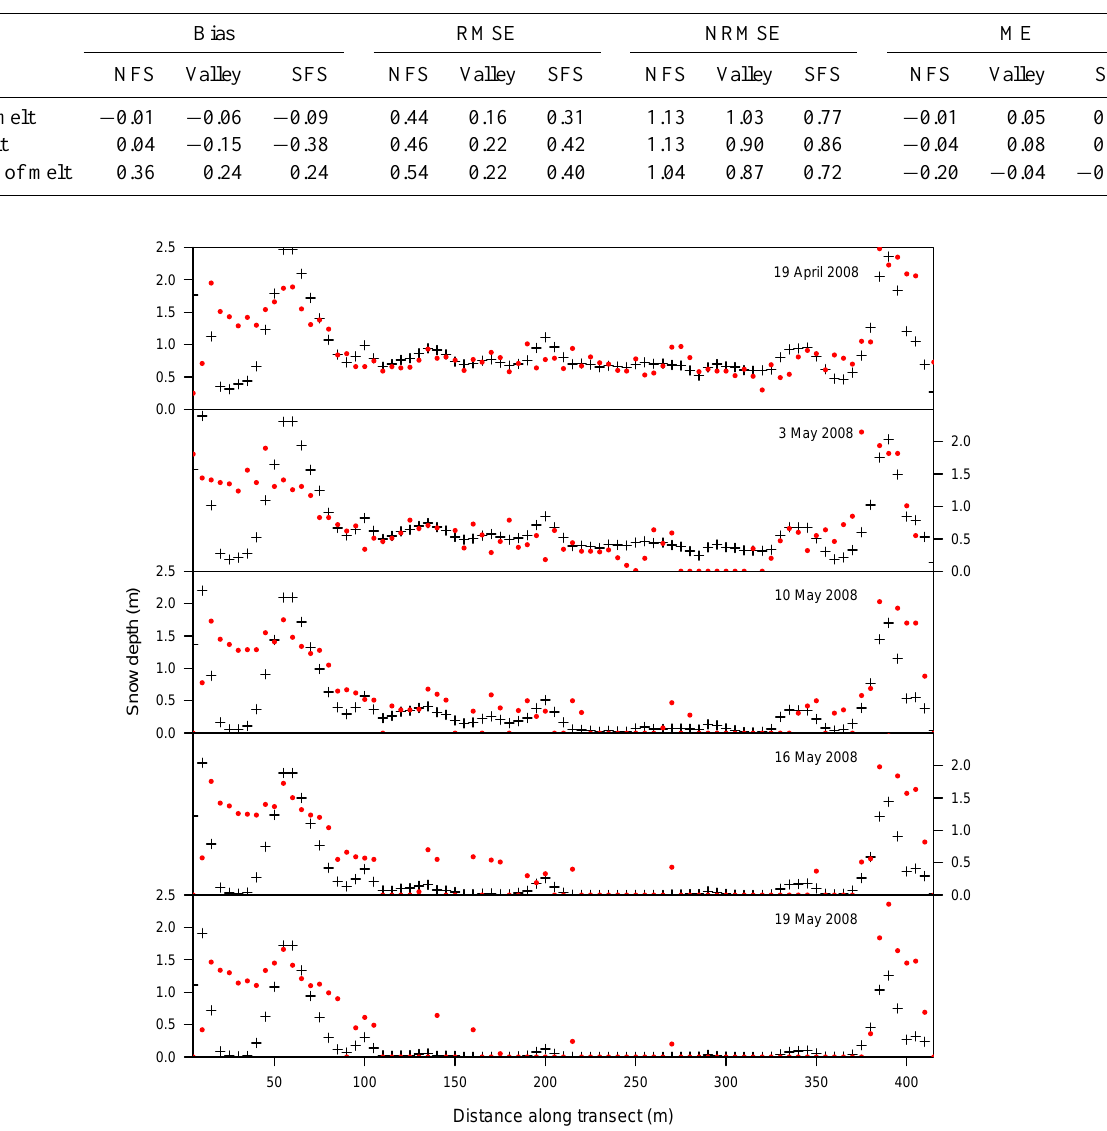
Figure 8. Modelled (black) vs. measured (red) snow depths along a transect in the GB valley. The transect goes through the northeast-facing slope (0–155m), the valley (155–240m) and the southwest-facing slope